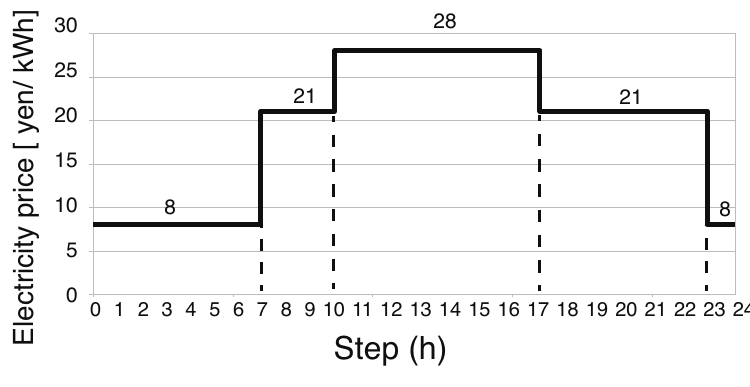
Figure 5. Price of electricity provided by power